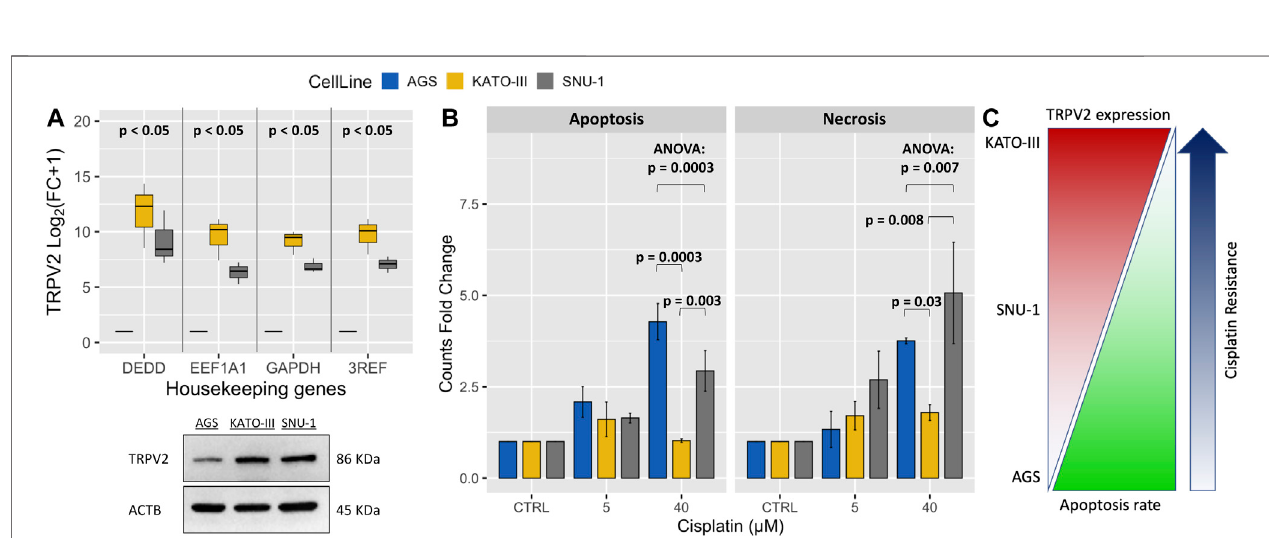
FIGURE2| AssociationofTRPV2expressionwithresistancetocisplatin-inducedcelldeathinGCcelllines. (A) RelativeqRT-PCRquanti fi cationofTRPV2mRNAin GC cell lines by using three reference genes. TRPV2 expression is reported as FC relative to that in the AGS cell line. In the lower panel, western blot analysis of TRPV2 expression in the three GC cell lines. (B) Assessment of apoptosis and necrosis rates in several GC cell lines after treatment with different concentrations of cisplatin. Statistical signi fi cance was estimated by ANOVA test and Tukey ’ s post hoc test on three replicates. (C) Schematic representation of correlation between TRPV2 expression and cisplatin resistance of different GC cell lines. 3REF: mean of fold change (FC) from the different housekeeping genes.